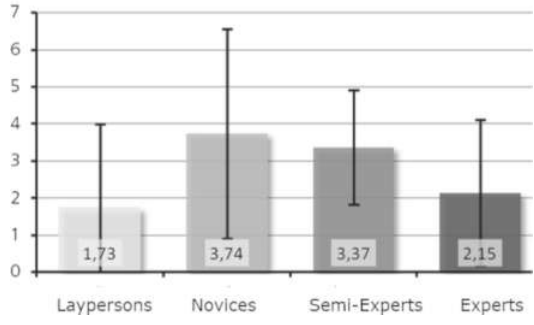
Figure 11. Revisits per minute on basic features